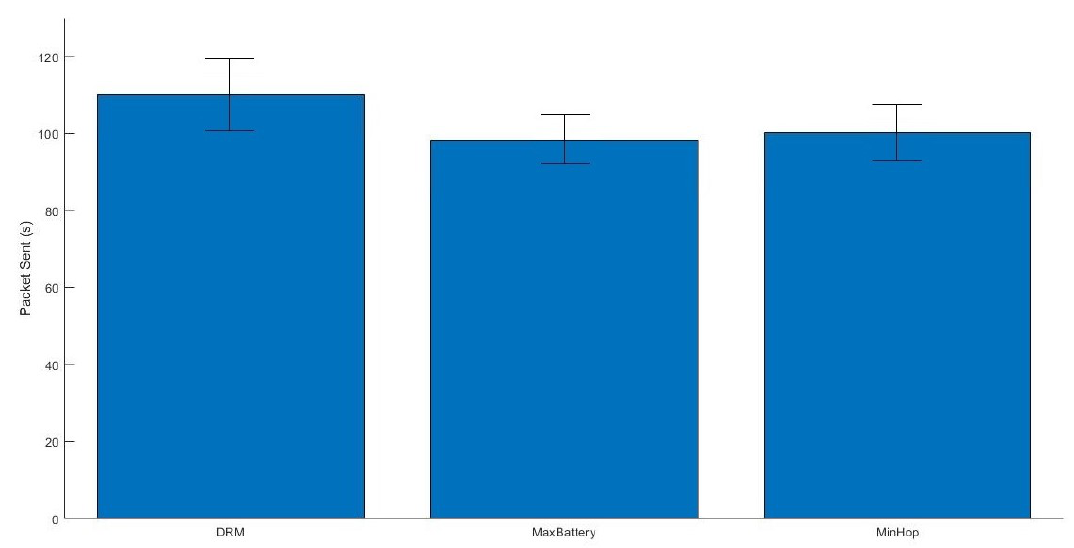
Figure 5. Comparison of proposed strategies MaxBattery, DRM and MinHop in terms of Average Latency.